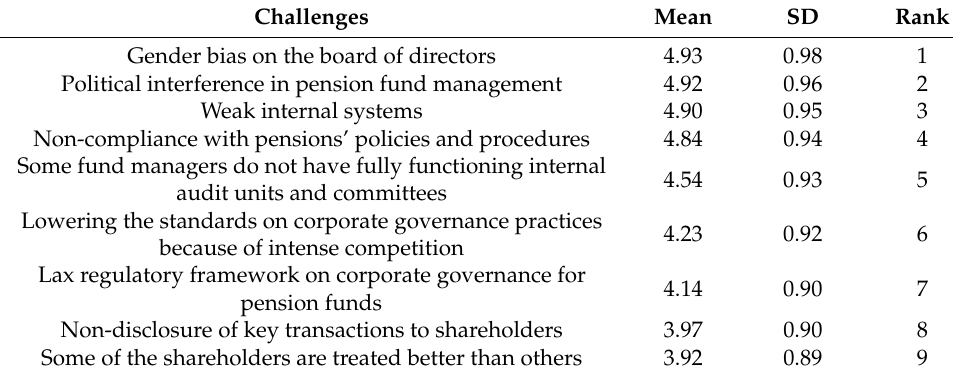
Table 8. Critical challenges of corporate governance of pension